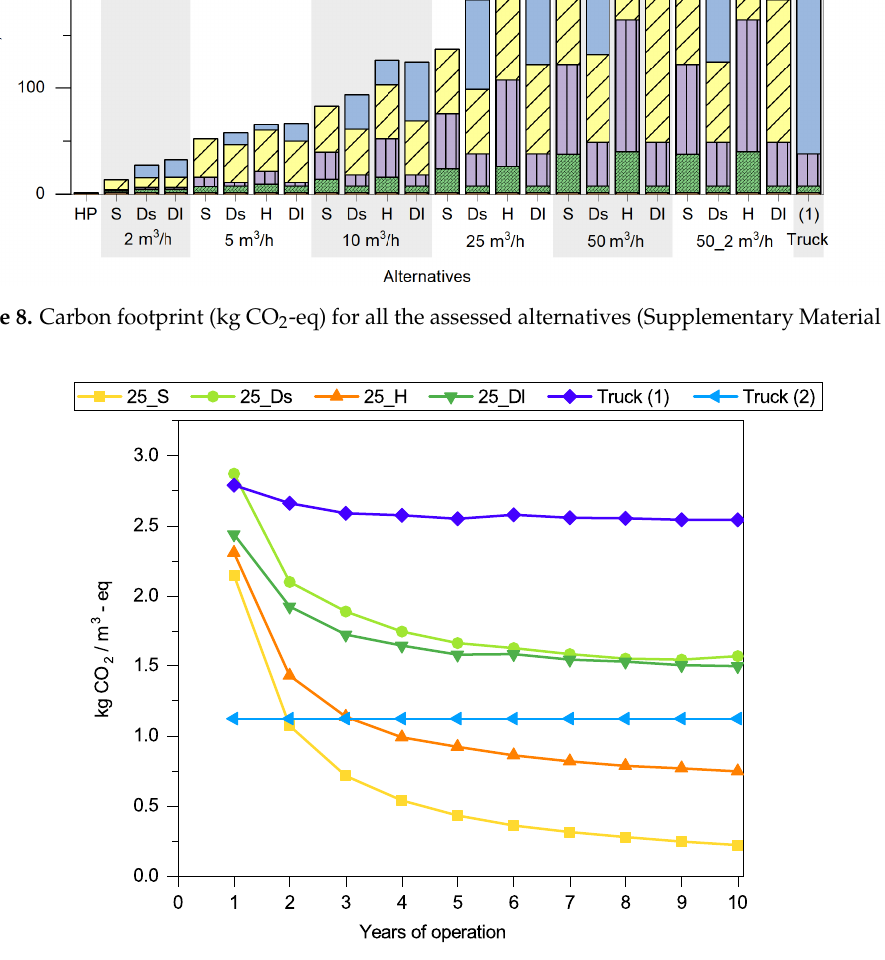
Figure 9. Unitary carbon footprint (kg CO 2 -eq/m 3 ) for the 25 m 3 /h alternative and water trucking. Details in Supplementary Material